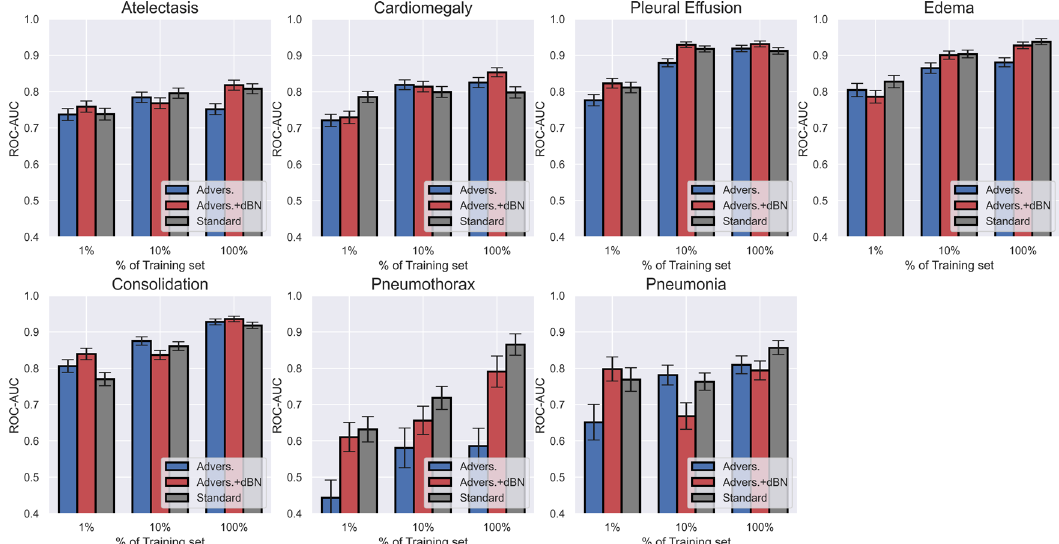
Fig. 3 More training data and dual batch norms are essential to accurate adversarial training. The classi fi cation performance of a standard, an adversarial (blue column), and an adversarially augmented model (red column)) with respect to different amounts of training data. In accordance with our hypotheses, the performance of adversarially trained models were boosted both by employing the dual batch norm and by enlarging the training set. In the case of pneumonia classi fi cation, the performance of adversarially trained models was limited and less stable due to an insuf fi cient amount of pneumonia positive cases in the dataset. Data are presented as mean values + / − SD (standard deviation). Note, n = 10,000 redraws are calculated in the bootstrapping analysis to get the mean and